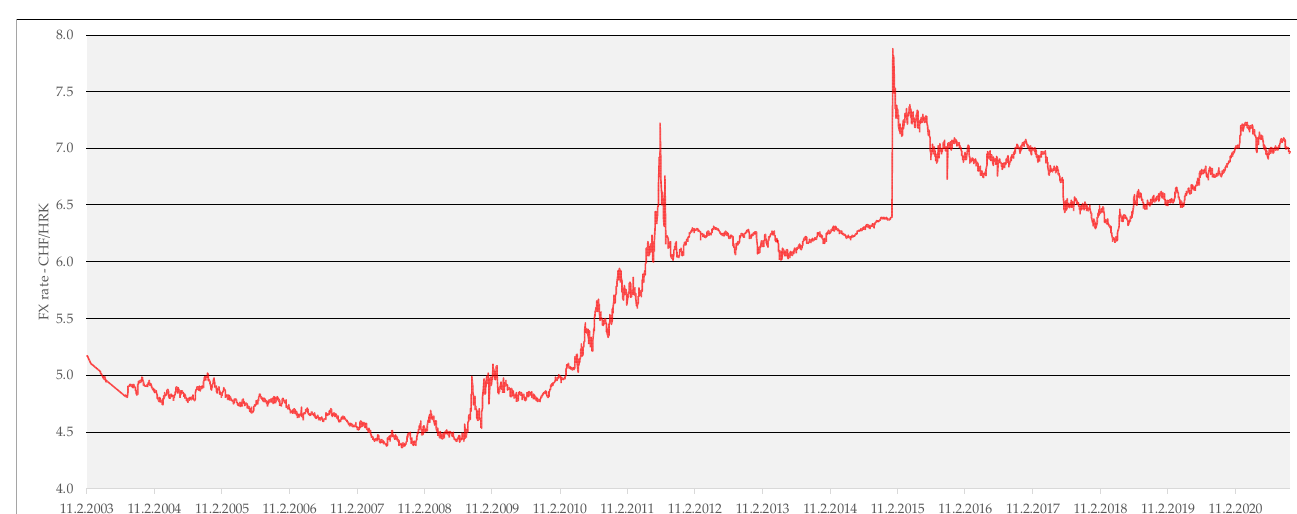
Figure 1. CHF/HRK FX mid-rate movement, daily data for the 11 February 2003–3 December 2020 period. Source: Author’s presentation of Bloomberg data.